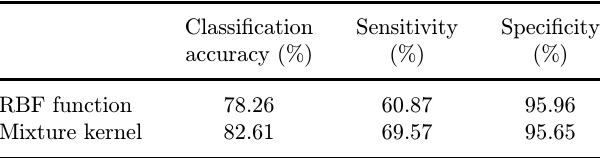
Table 3. Results of classi¯cation with RBF kernel and mix- ture